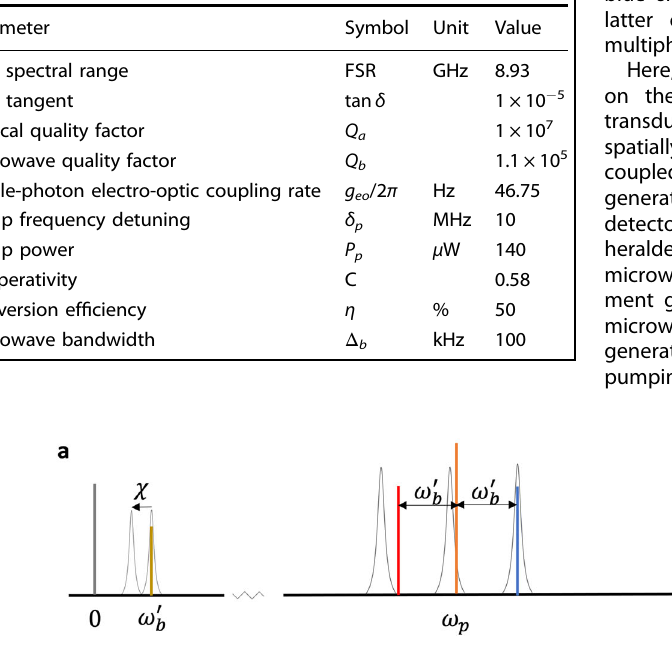
Table 1. Main design parameters and fi gures of merit for the presented 3D transduction device based on the coupling of an SRF cavity and an electro-optic